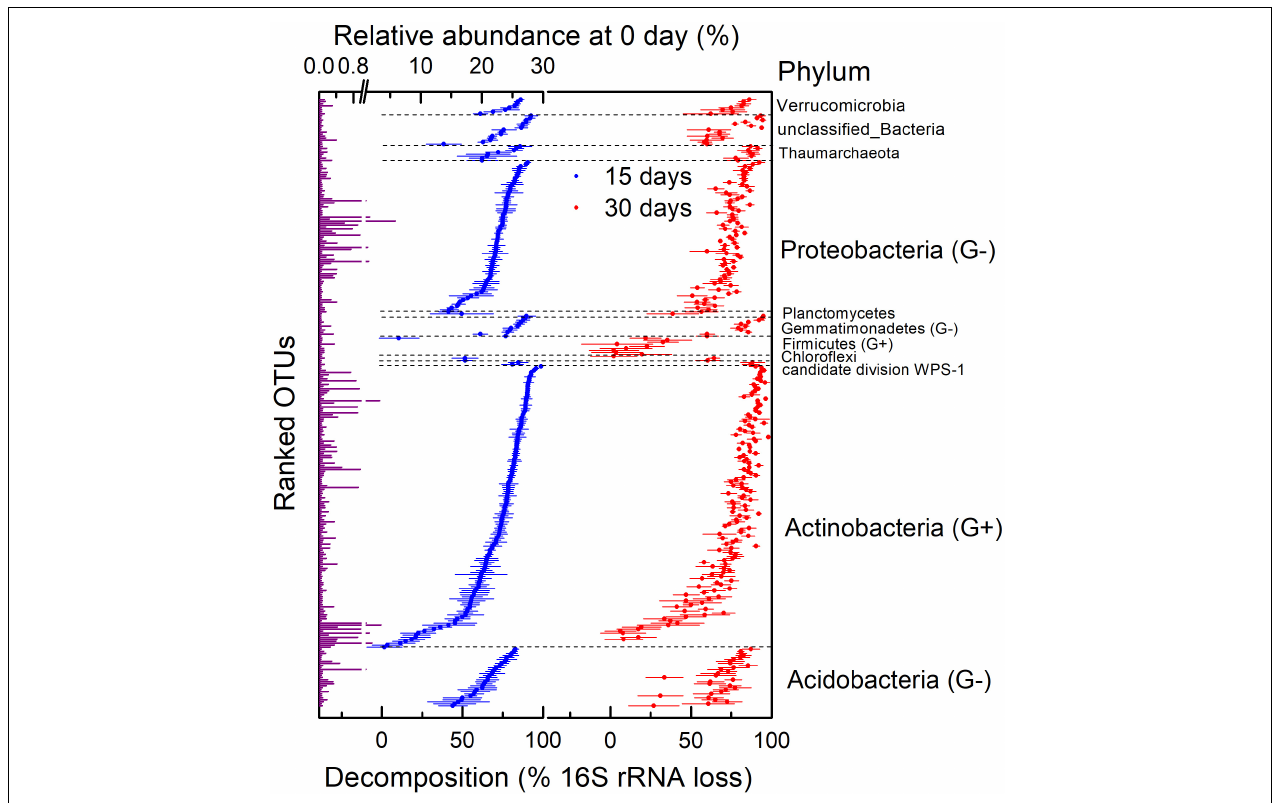
FIGURE 4 | Relative abundance on 0 day and decomposition of 16S rRNA gene at operational taxonomic unit (OTU) level in H 218 O light fraction (dead bacteria and archaea) at different times. This was assessed by calculating percentage of absolute abundance loss of 16S rRNA gene after 15 and 30 days. G + in parentheses represents gram-positive bacteria, and G − in parentheses represents gram-negative bacteria. Points are average of four replicates, and bars show standard errors of means with four